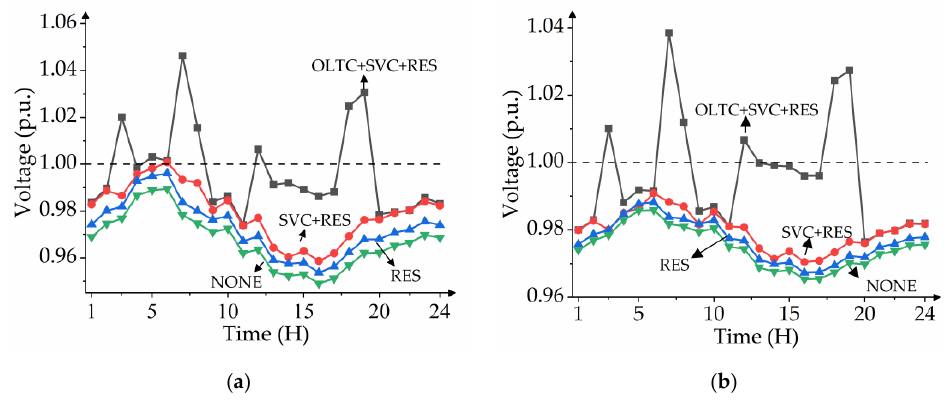
Figure 1. The result of the day-ahead optimization. ( a ) The day-ahead voltage profile of bus 14. ( b ) The day-ahead voltage profile of bus 26.